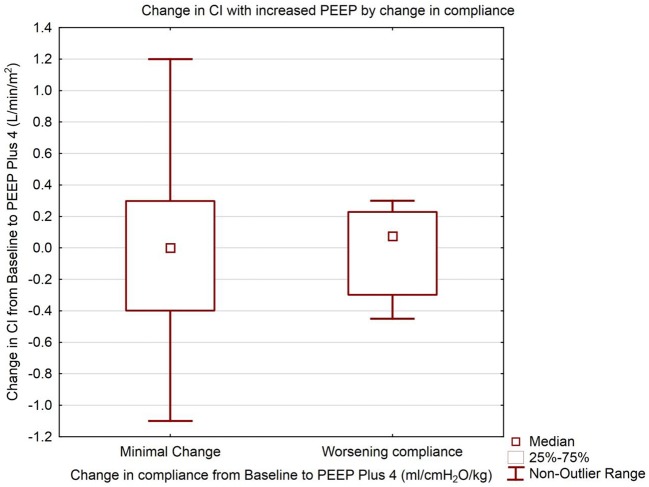
Change in Cardiac Index with increased PEEP. Groups separated by change in dynamic compliance of the respiratory system. Data are presented as median, inter-quartile, and non-outlier range. The left box represents change in cardiac index from Baseline to PEEP plus 4 cmH2O where there was minimal or no change in the respiratory compliance from Baseline to PEEP plus 4 cmH2O. The right box represents the change in cardiac index for subjects where the respiratory compliance worsened from Baseline to PEEP plus 4 cmH2O. There is no statistically significant difference between the change in cardiac index between the two groups (Mann Whitney U test, p = 0.91).